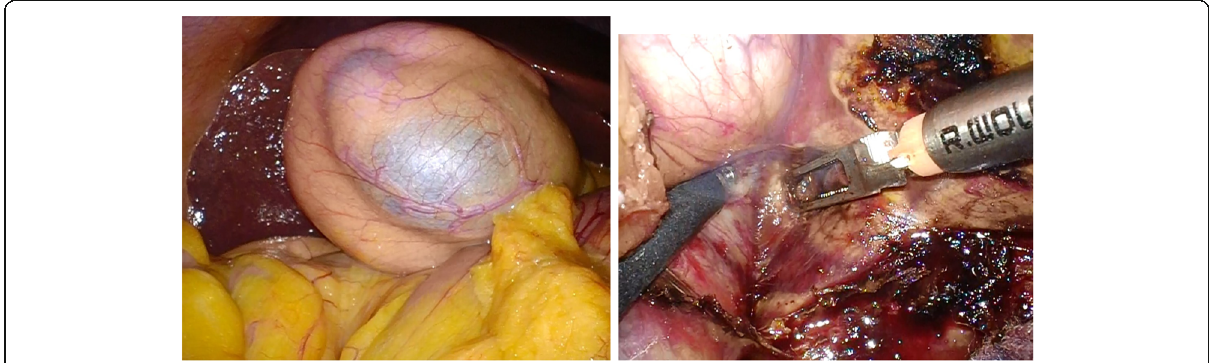
Fig. 4 Intraoperative laparoscopy found a relatively soft tumor behind the gallbladder with dorsal compression of the